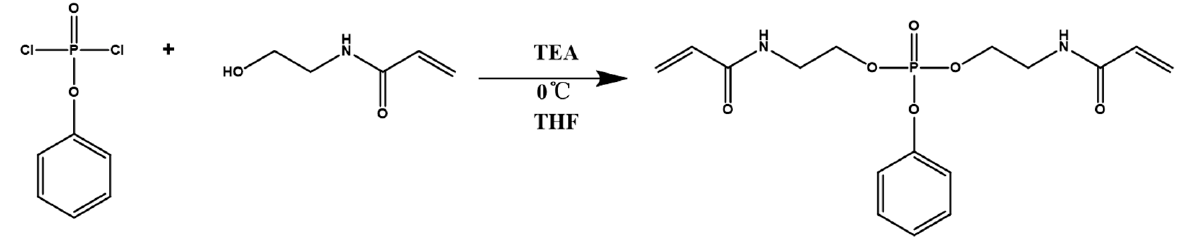
Table 1. Formulation and flame retardancy of the UV-cured coatings.